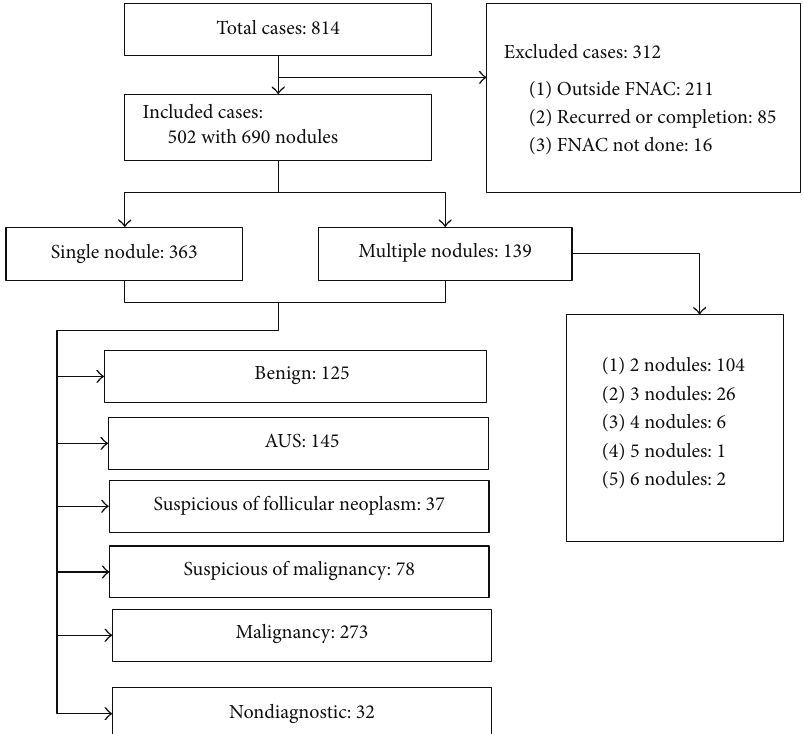
Figure 1: The patients and thyroid nodules in the present study. FNAC: fine-needle aspiration cytology; AUS: atypia of undetermined significance.